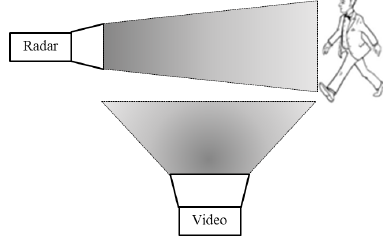
Figure 7. Video capturing a human